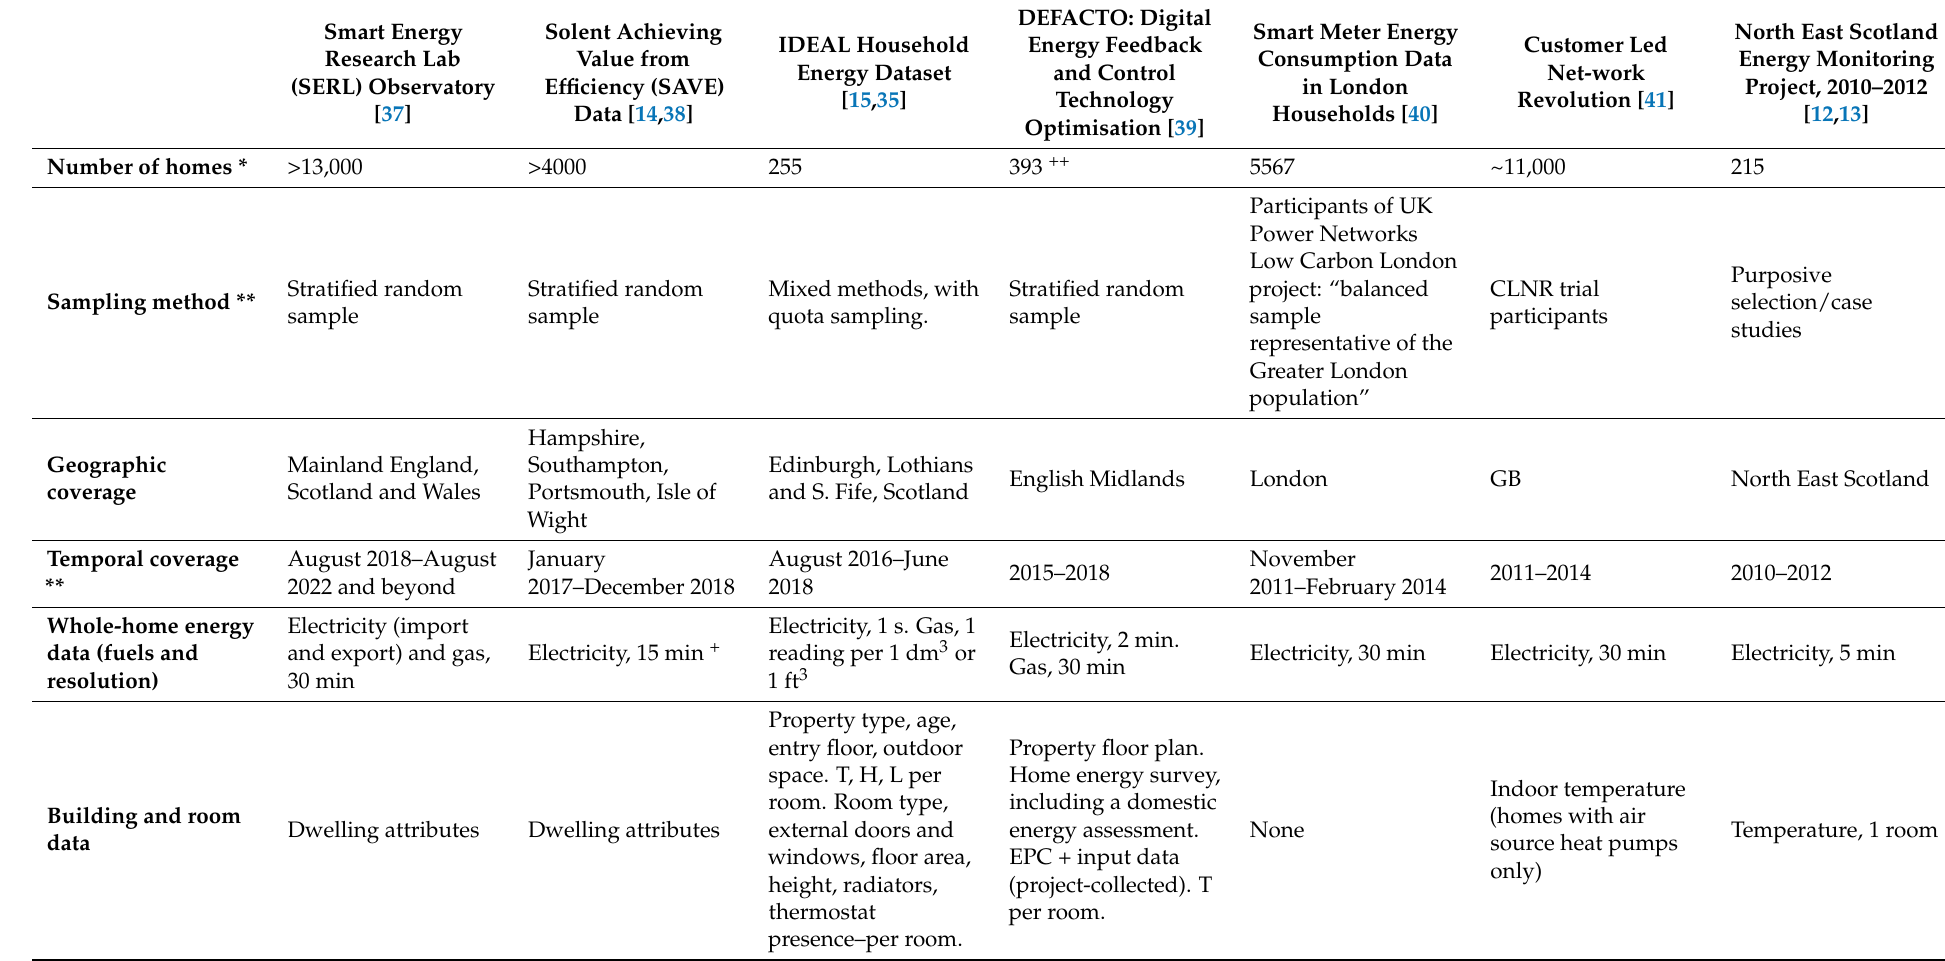
Table A1. Previously released energy datasets with comparable features to the SERL dataset, most recent first (by end of data collection). See Section 1 for criteria for inclusion of datasets described in this table. ‘T’ stands for temperature sensor data, ‘H’ for humidity, ‘L’ for light level, ‘EV’ for electric vehicle. See below table for additional relevant notes. Datasets were identified from: Elam 2016 [44], CEEDS: The Centre for Energy Epidemiology Data Service 2017 [45], Pullinger et al. 2021 [46], Georgia Tech n.d. [47], authors’ existing